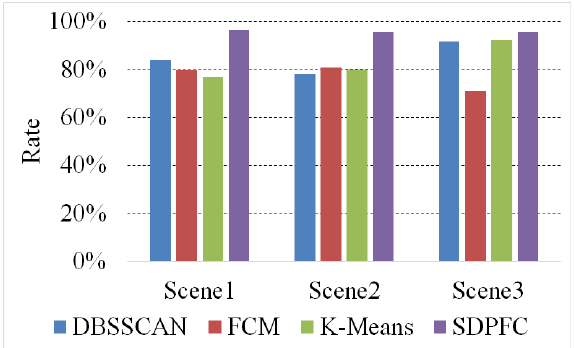
Figure 16. Clustering accuracy